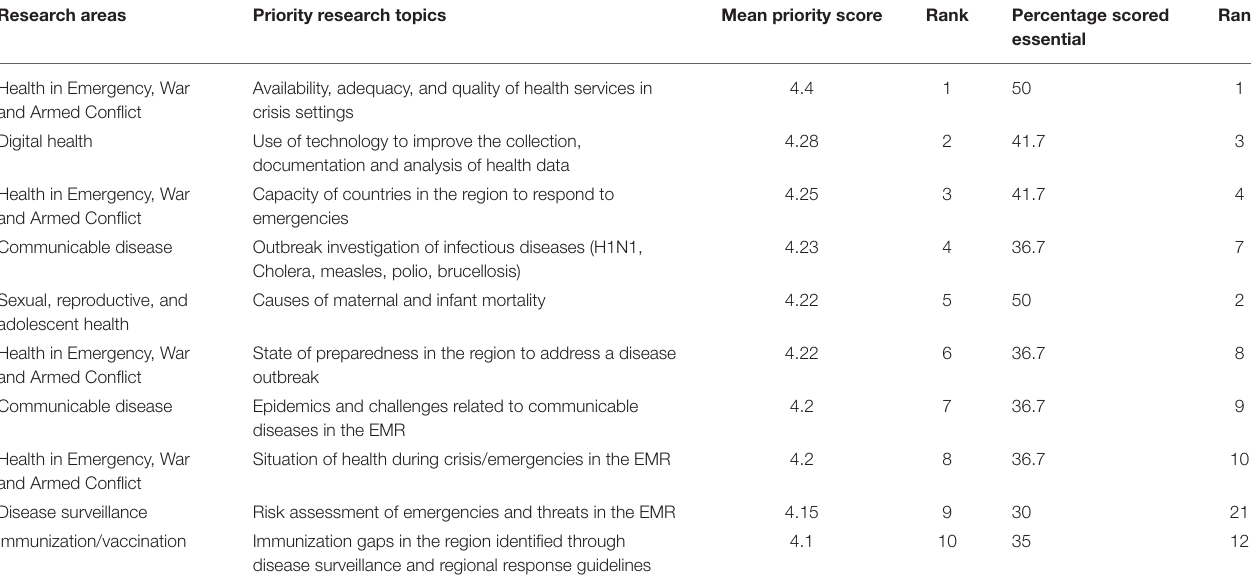
TABLE 2 | The top 10 priority research topics in public health and field